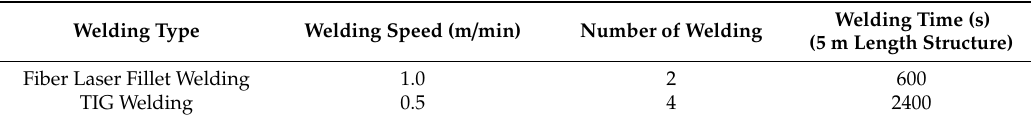
Table 11. Estimated effectiveness in comparison with TIG welding.